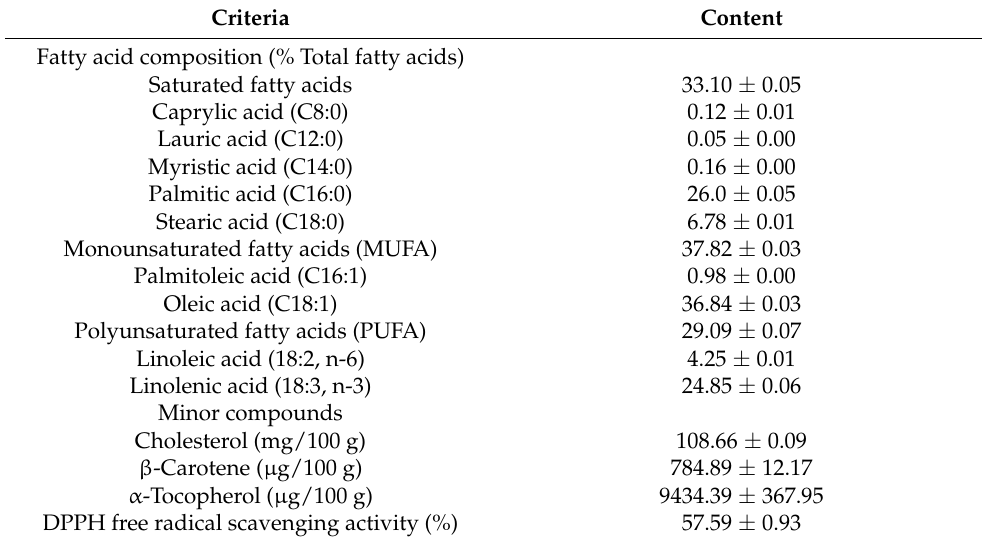
Table 5. The fatty acid composition, content of minor compounds, and DPPH free radical scavenging activity of silkworm pupae oil extracted by aqueous saline